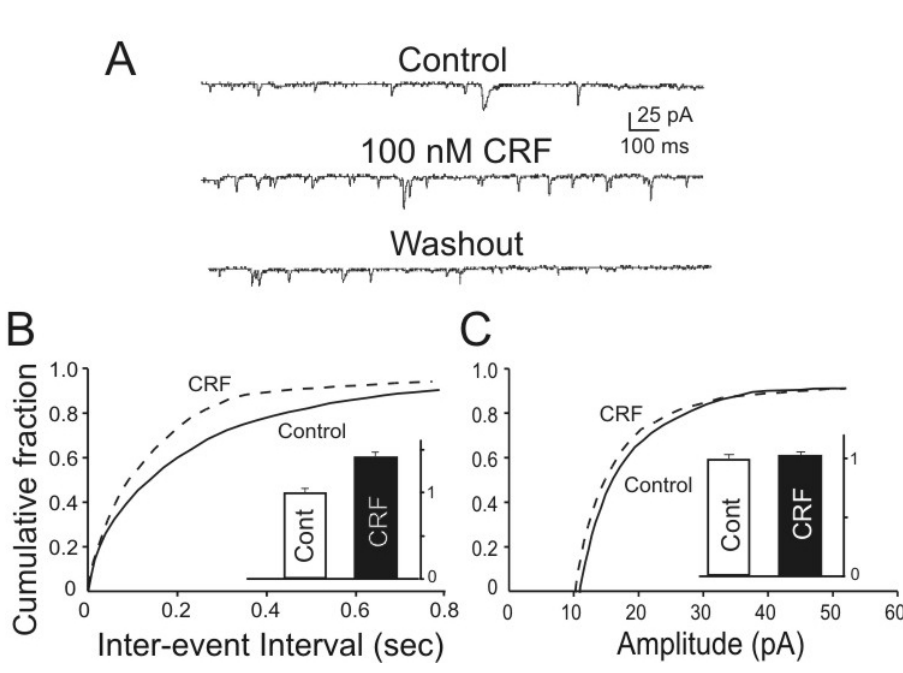
FIGURE 6. CRF enhances the frequency of spontaneous GABA A ergic mIPSCs in CeA neurons from WT mice. (A) Representative current traces recorded from a CeA neuron in the presence of 1 µ M TTX and glutamate blockers. Superfusion of 100 n M r/hCRF clearly increases the frequency of the mIPSCs, with little obvious effect on their amplitude, with recovery on washout. Number of recorded events: Control, 9; CRF, 23; washout, 13. (B) Cumulative frequency histograms for a representative CeA neuron from WT mice showing a shift to the left, indicating briefer inter-event intervals (higher frequencies) during the application of 100 n M r/hCRF. (C) Cumulative amplitude histograms from the same CeA neuron showing little r/hCRF effect on the distribution of mIPSC amplitudes in CeA neurons from WT mice. Inset graphs are pooled data from six CeA neurons, showing that mean mIPSC frequency is significantly ( p < 0.05) increased, but mean amplitude is not changed by